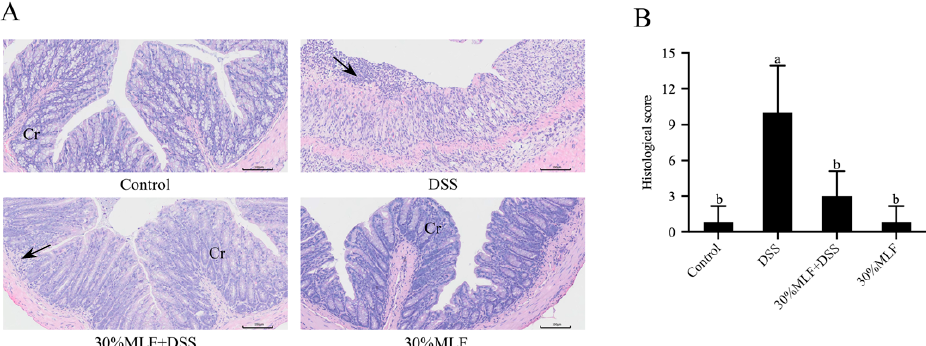
Figure 8. Effect of 30%MLF on the colonic pathological damage in mice with DSS-induced ulcerative colitis. ( A ) Representative images showing colon pathologic damages with H&E staining, where Cr indicates the crypt, and arrows indicate inflammatory cell infiltration. ( B ) Histological scores of colons. Data are presented as the means ± SD ( n = 6). Columns with different superscript letters are significantly different ( p < 0.05).